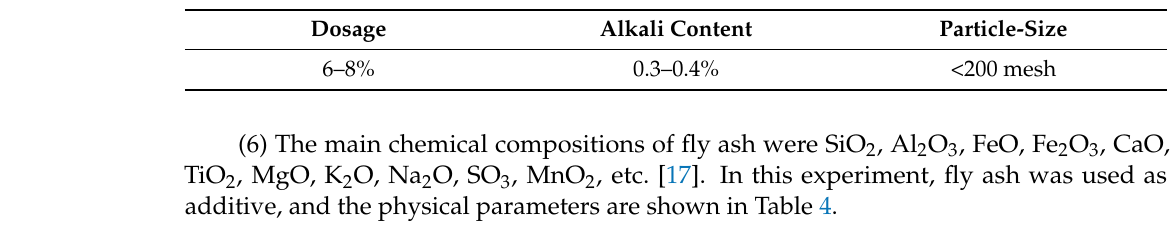
Table 4. Physical parameters of fly